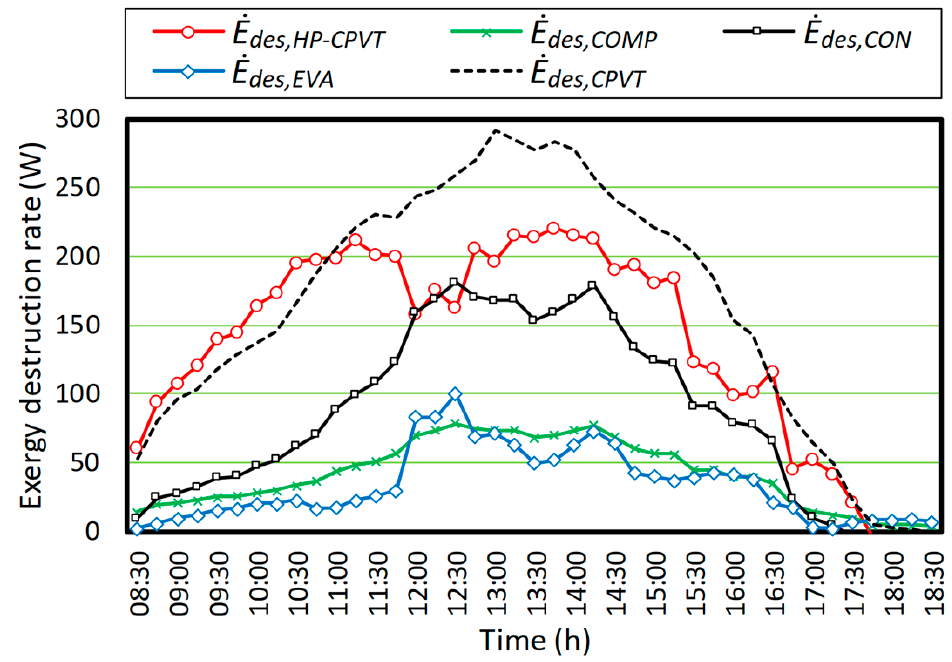
Figure 11. Changes in the exergy destruction rate for some components of the HP-CPVT system (yjr black dashed line indicates the CPVT-only system).